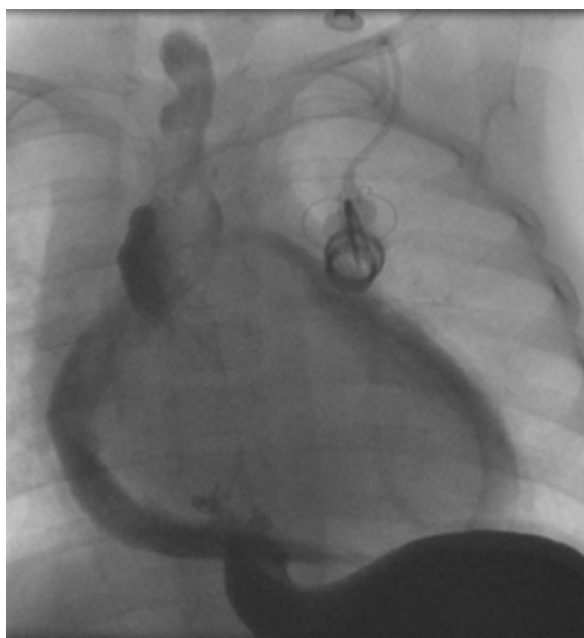
Fig. 2 On day 1 postesophageal dilatation, the lining of the peri- cardium is visualized by the extravasation of the contrast during an upper gastrointestinal